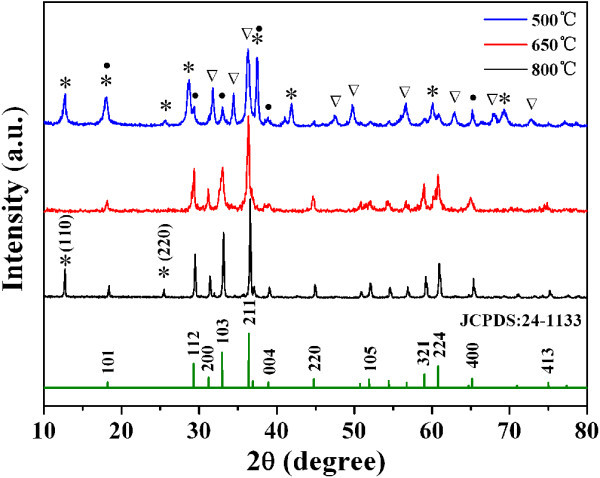
XRD patterns of the ZnMn2O4 nanorods at different calcined temperatures and as per the standard card about ZnMn2O4 (JCPDS file No.24-1133). Asterisks, α-MnO2; inverted triangle, ZnO; filled circle, ZnMn2O4.